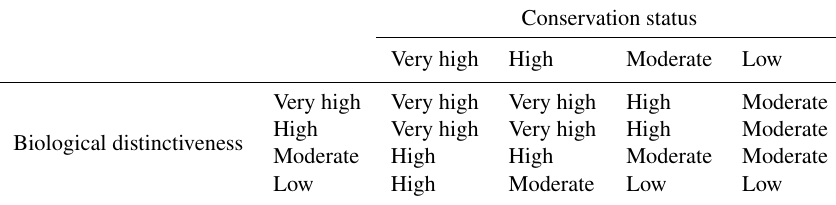
Table 6. Criteria for assigning ecoregions to the different categories of adaptation to fire regimes. Relationship between fire and ecoregion